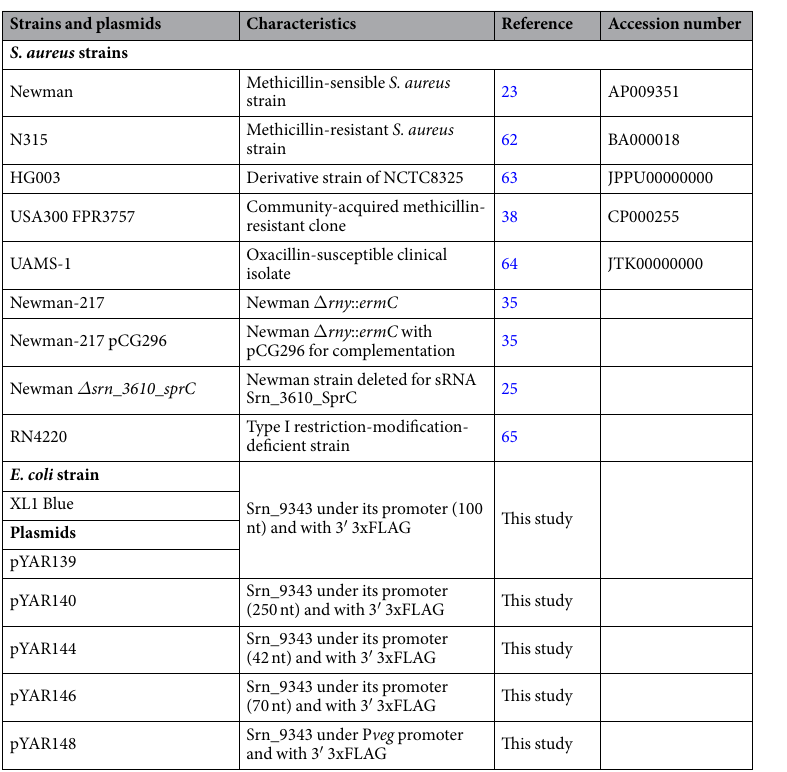
Table 6. Bacterial strains and plasmids used in this